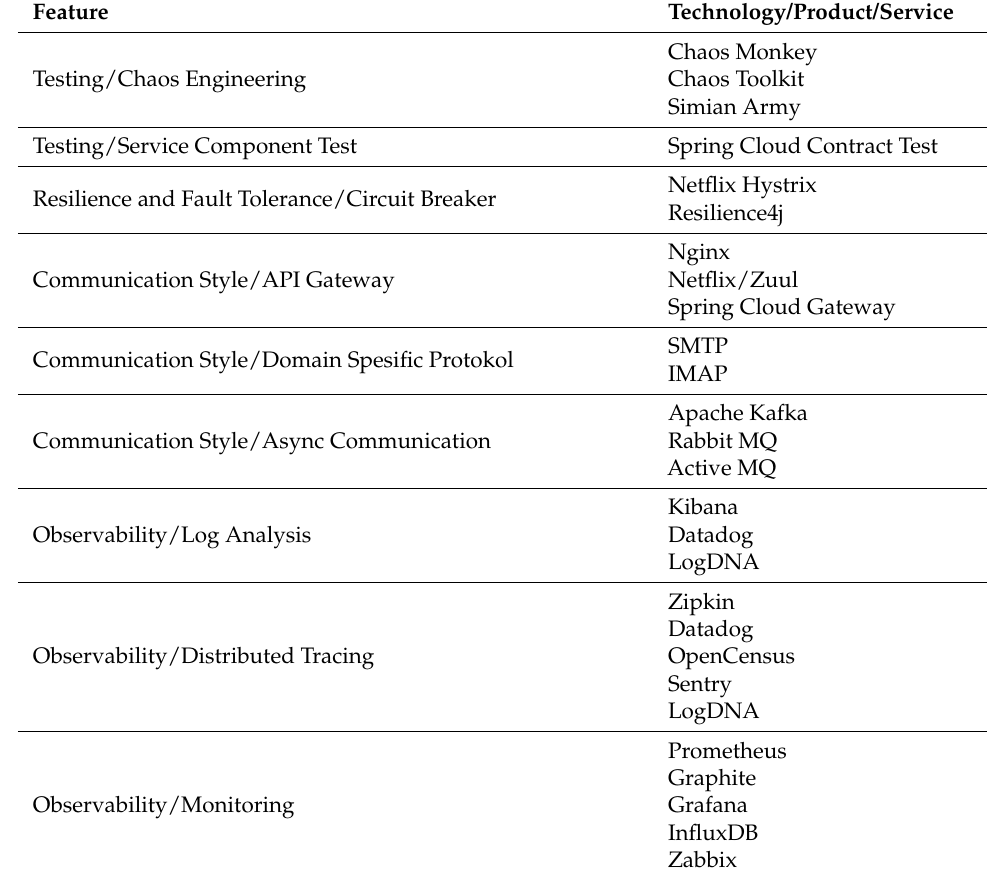
Table 2. Mapping features with MSA